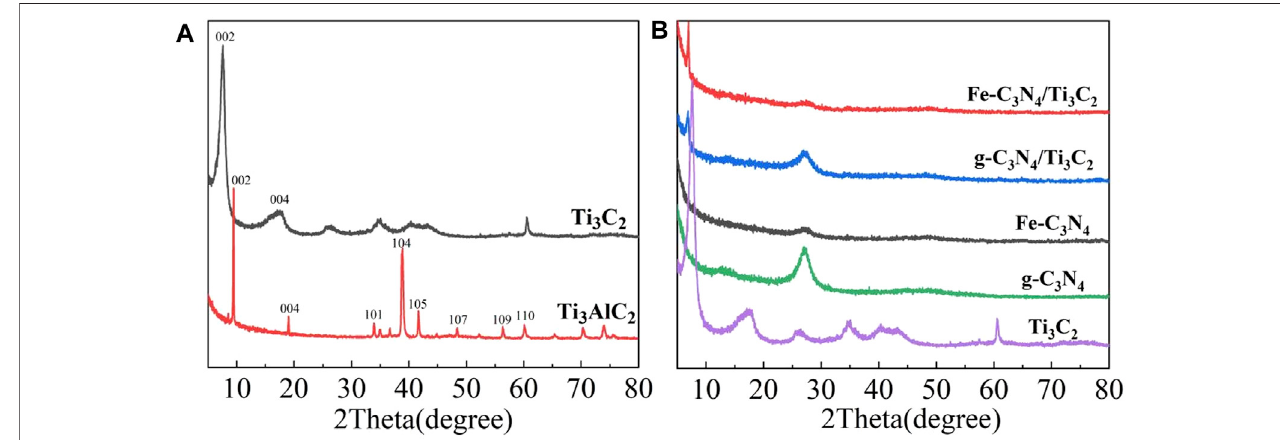
FIGURE 1 | (A) XRD pattern of Ti 3 C 2 and Ti 3 AlC 2 . (B) XRD pattern of the Ti 3 C 2 , g-C 3 N 4 , Fe-C 3 N 4 , g-C 3 N 4 /Ti 3 C 2, and Fe-C 3 N 4 /Ti 3 C 2